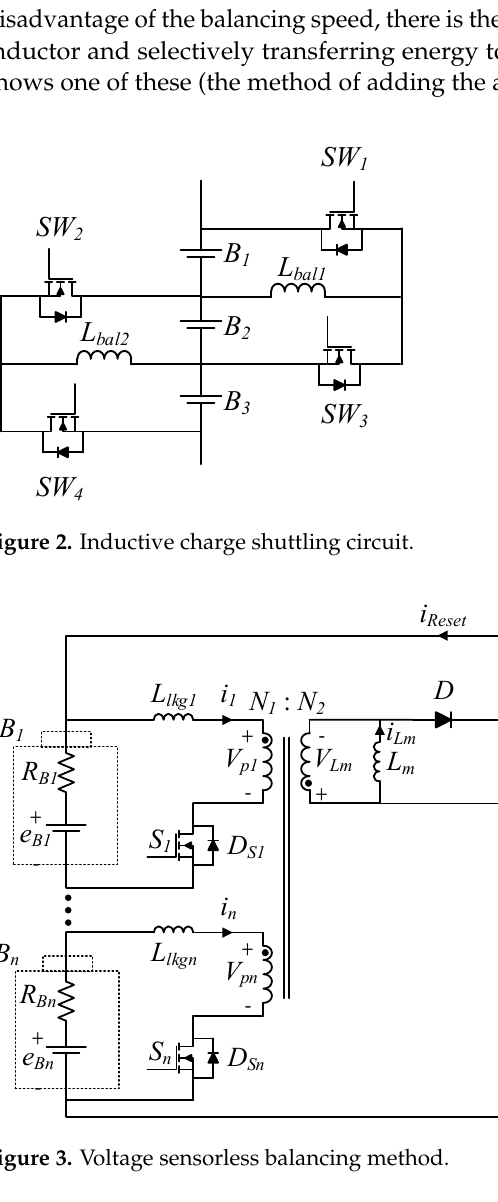
Figure 4. Voltage sensorless balancing method.